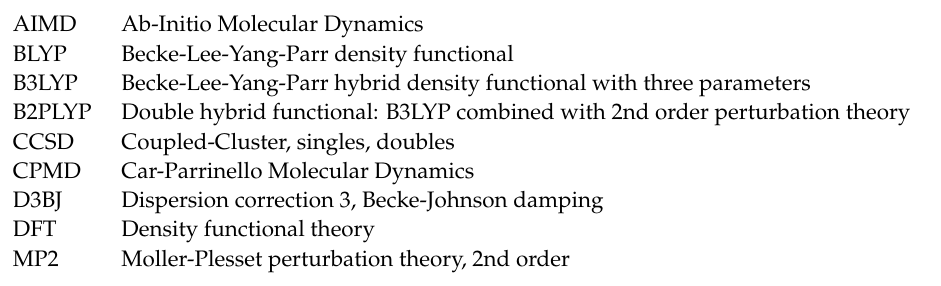
neighbors, first nitrogen atom; Figure S14: Simulation 4 : Distances of the nearest neighbors, second nitrogen atom; Figure S15: Simulation 11 : Formation of the N-H bond, breaking of the N-N and H-H bonds; Figure S16: Simulation 20 : Formation of the N-H bond, breaking of the N-N and O-H bonds; Figure S17: Simulation 24 : Formation of the N-H bond, breaking of the N-N and H-H